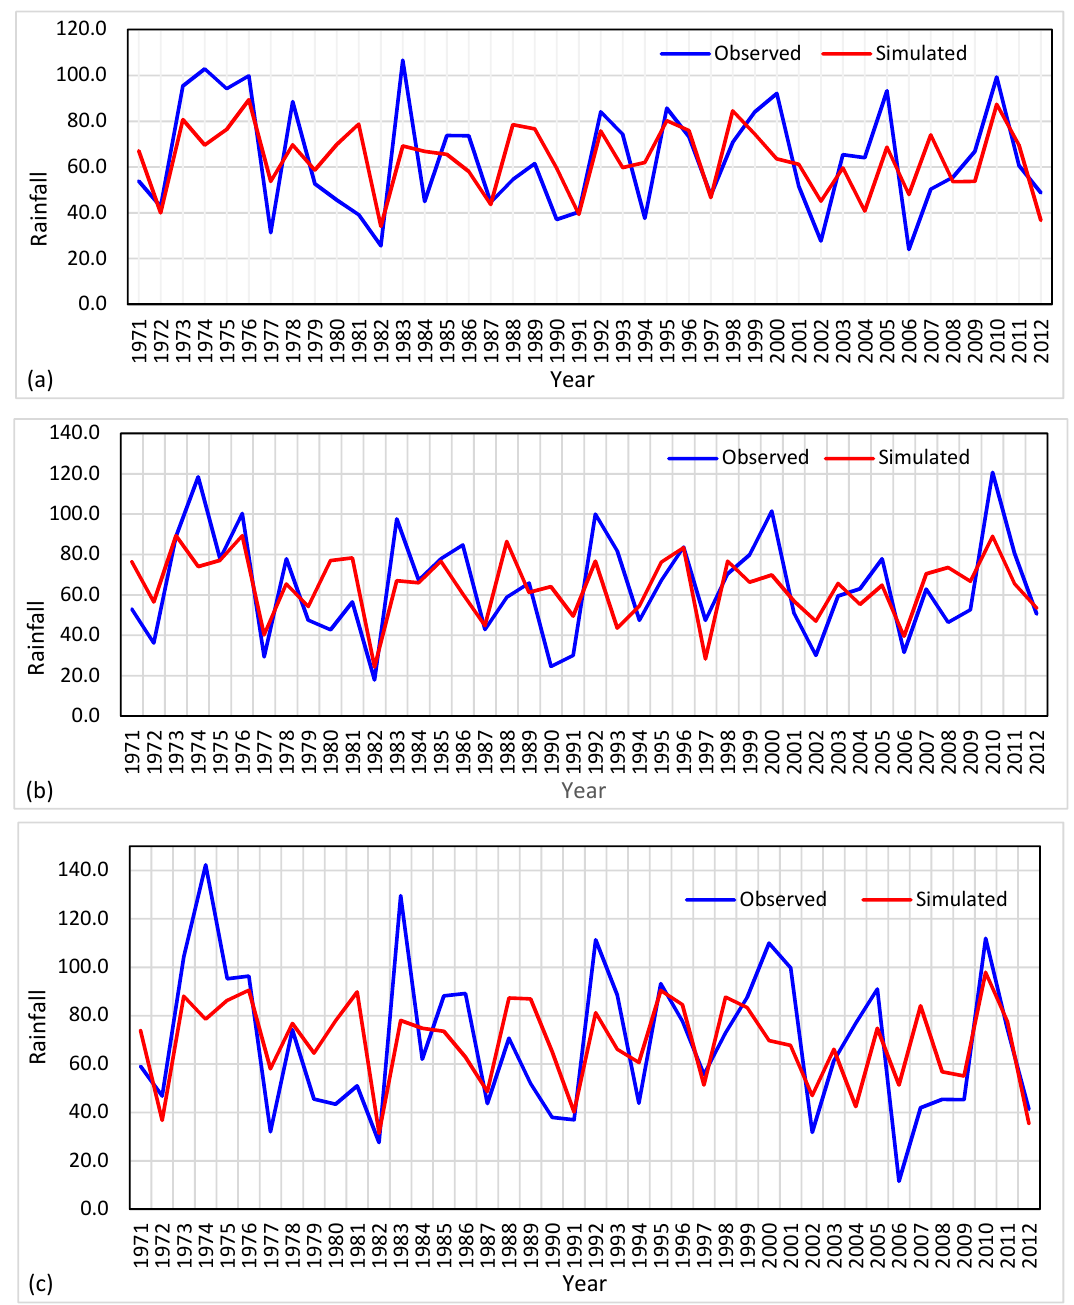
Figure 3. Comparison of the modelling output during the calibration period. ( a ) Ainslie Tyson St; ( b ) Tharwa General Store; ( c ) Huntly.